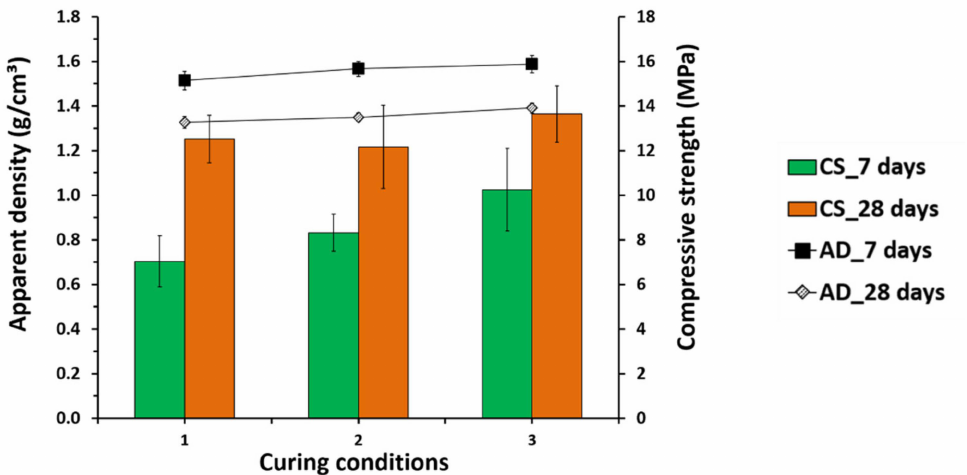
Figure 7. The apparent density and compressive strength of the alkali activated binders at 7 and 28 days of curing as a function of the curing conditions used as per Table